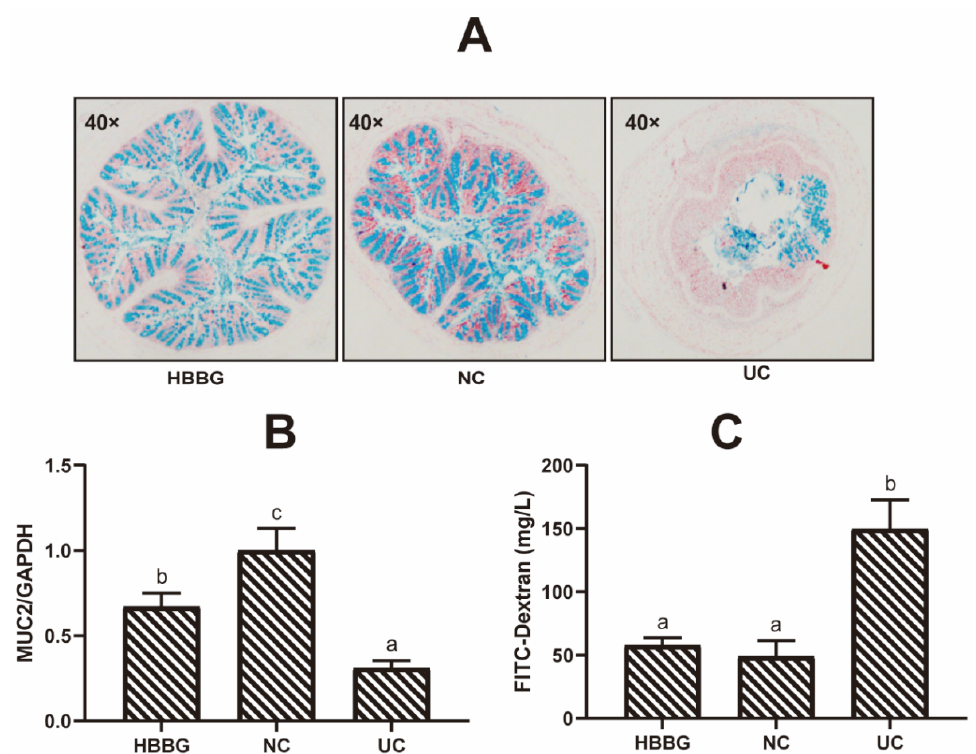
Figure 2. The effects of HBBG on intestinal permeability: ( A ) Alcian blue staining; ( B ) the relative transcriptional levels of the gene encoding MUC2; ( C ) the concentration of Dextran-FITC in the blood samples. Different letters indicate statistically significant differences ( p < 0.05); on the contrary, the same letters indicate no statistically significant differences ( p > 0.05).